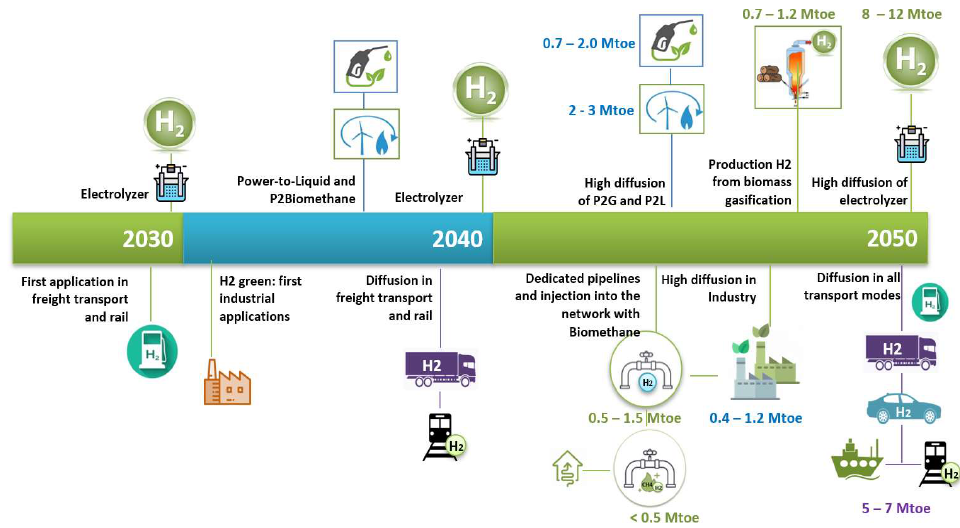
Figure 16. Evolution of hydrogen energy uses in LTS scenarios; Mtoe.